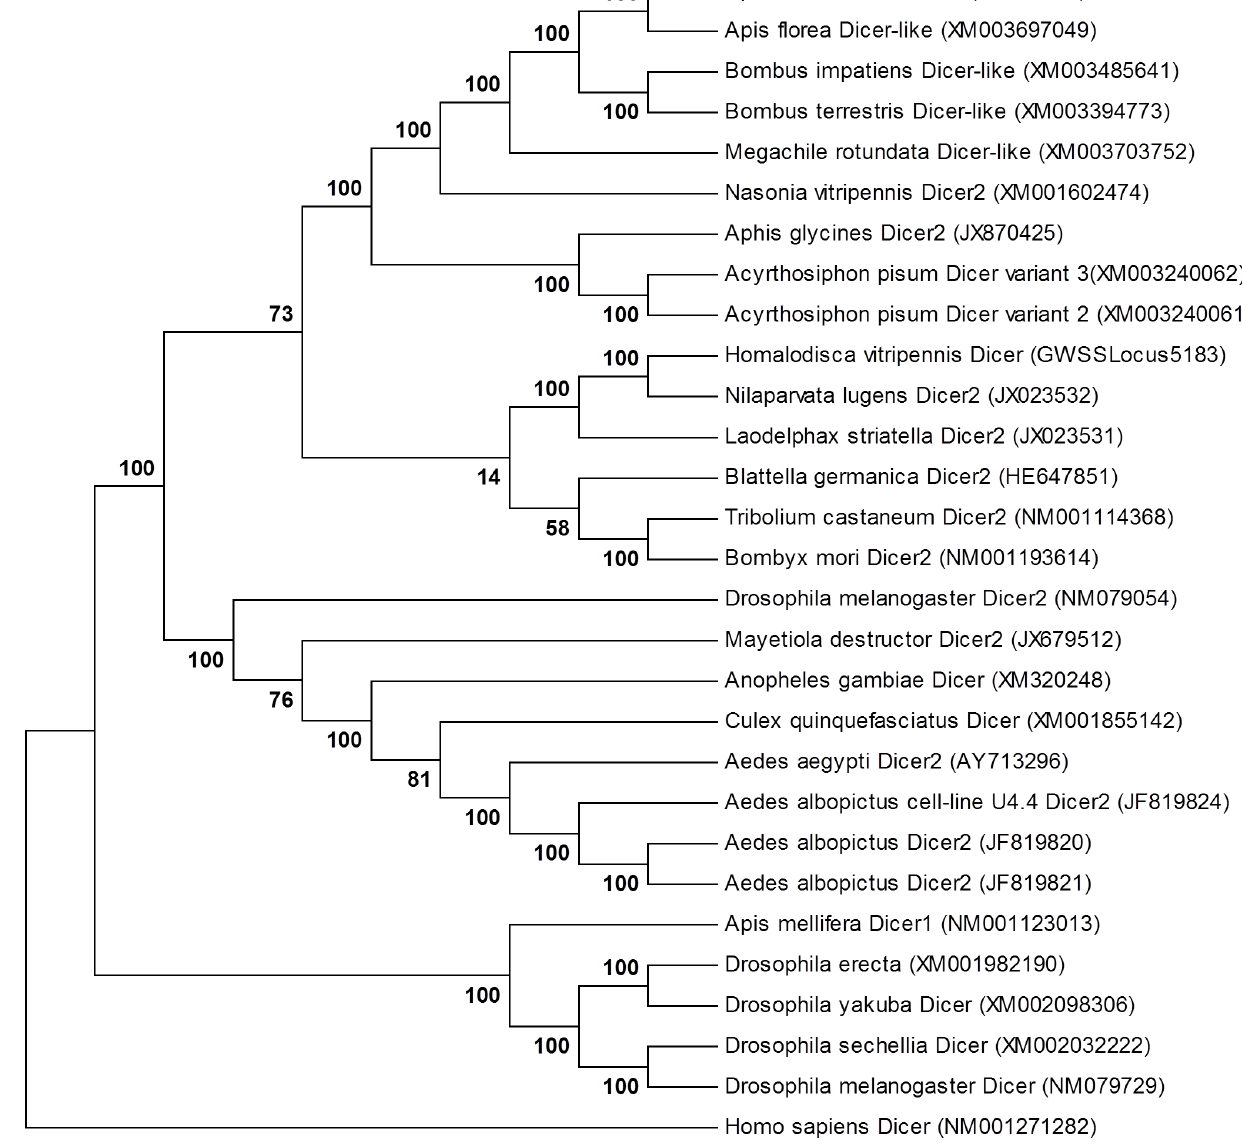
Figure 6. Distribution and phylogeny of deduced H.vitripennis Dicer proteins. The evolutionary relationship of H. vitripennis Dicer protein with other insect Dicer proteins is shown. The bootstrap consensus tree inferred from 500 replicates is taken to represent the evolutionary history of the taxa analyzed. Branches corresponding to partitions reproduced in less than 50% bootstrap replicates are collapsed.